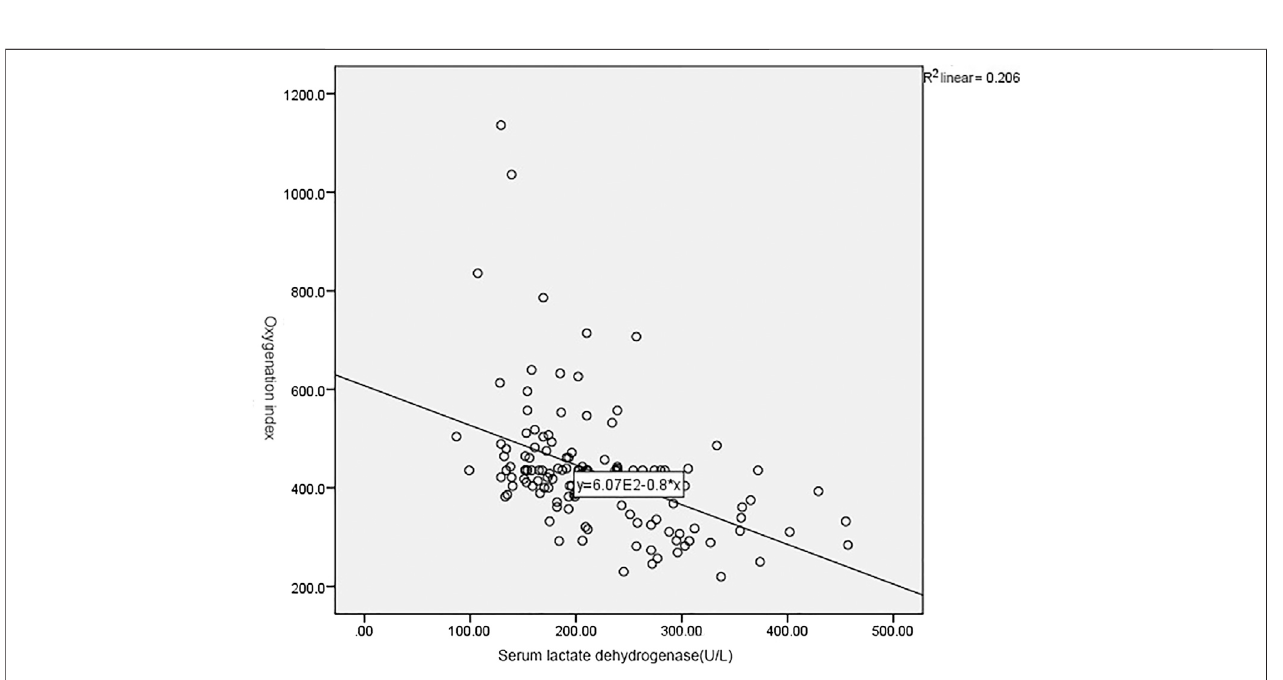
FIGURE 2 | Correlation between LDH and oxygenation